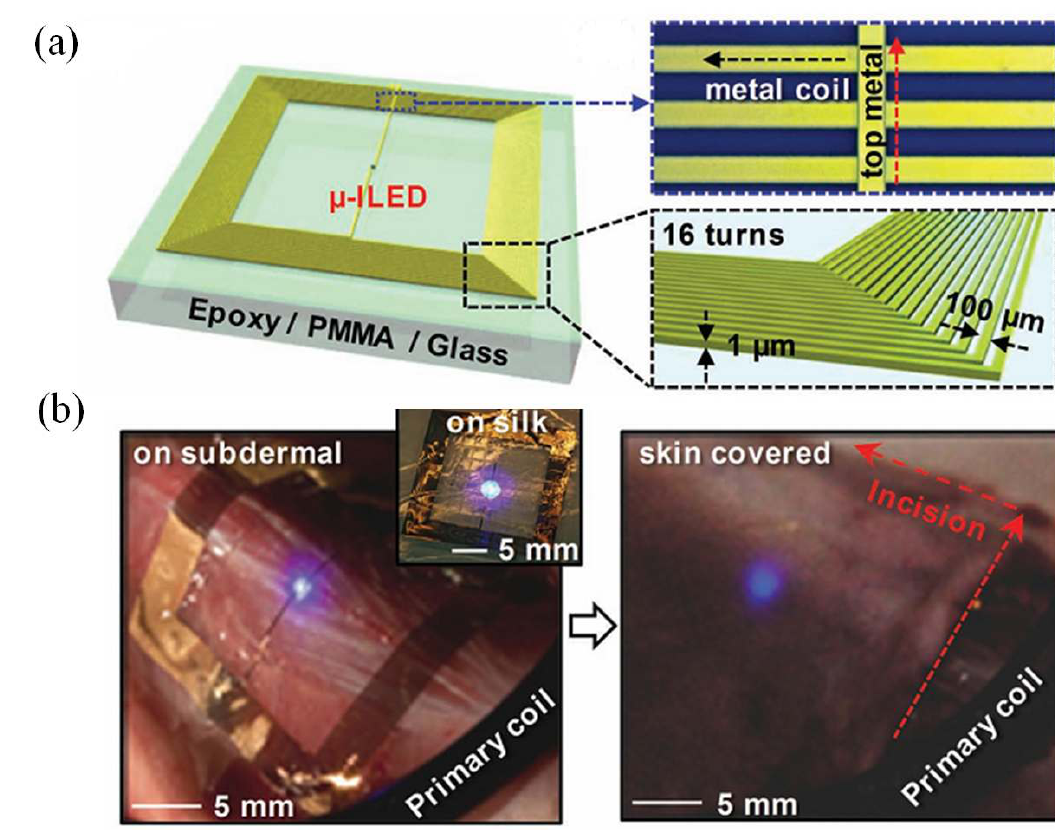
Figure 8: (a) Schematic illustration of the wireless µ-LED device design. The spiral inductor coils are used to power the connected µ-LED wirelessly. Inset pictures show the enlarged top interconnects and wireless coil design. (b) Optical images of the wirelessly powered µ-LED laminated onto a mouse model (left) and covered with dermis (right). Reproduced with permission from